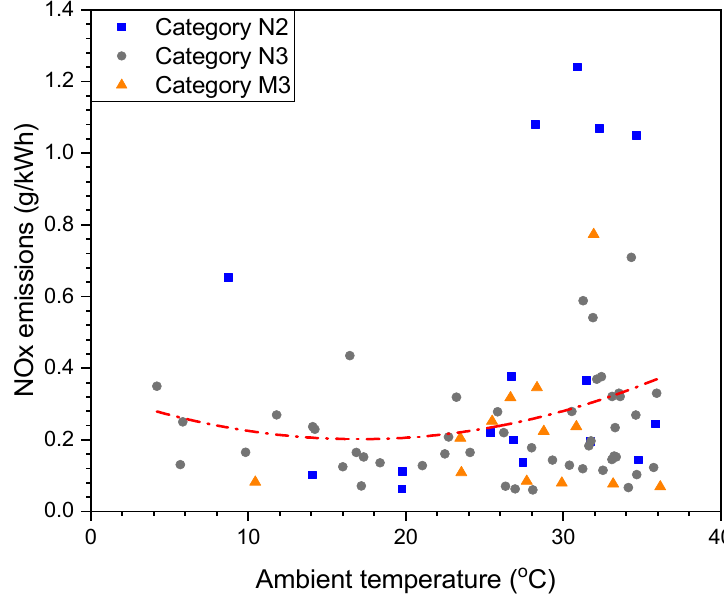
Figure 7. On-road NOx emissions from Euro 6 heavy-duty vehicles relative to the ambient temperature.